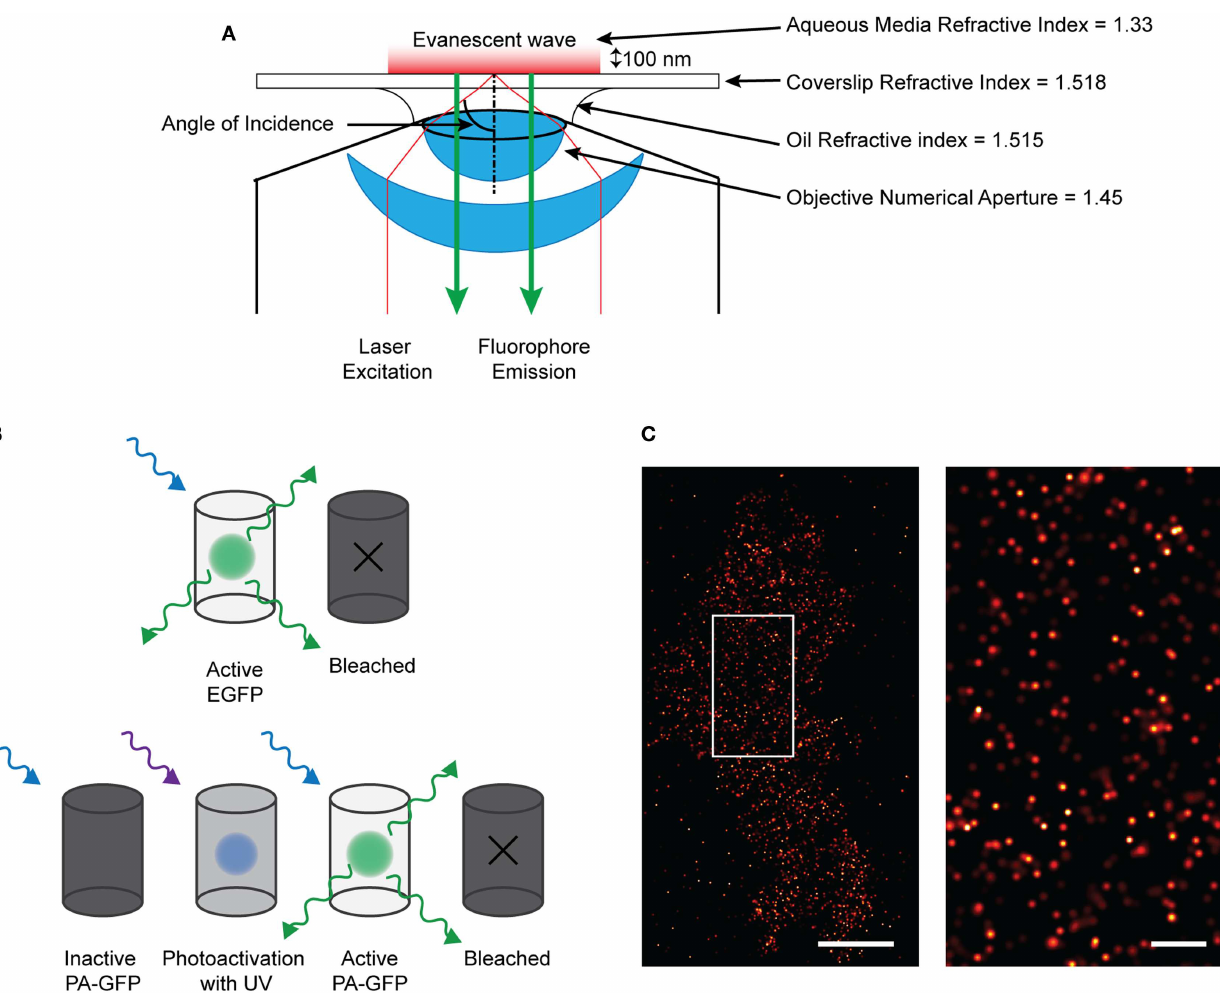
FIGURE 1 | Single molecule imaging using PALM technique. (A) Diagram of theTIRF microscopy setup. By angling the excitation light beam though a combination of the refractive indices of the lense, oil, coverslip, and aqueous media, the beam is reflected at the glass/media interface and is directed back into the objective.This creates an evanescent wave at the interface which effectively excites fluorophores only about 100 nm into the sample.Therefore only those fluorescent proteins or dyes within that region will be excited and